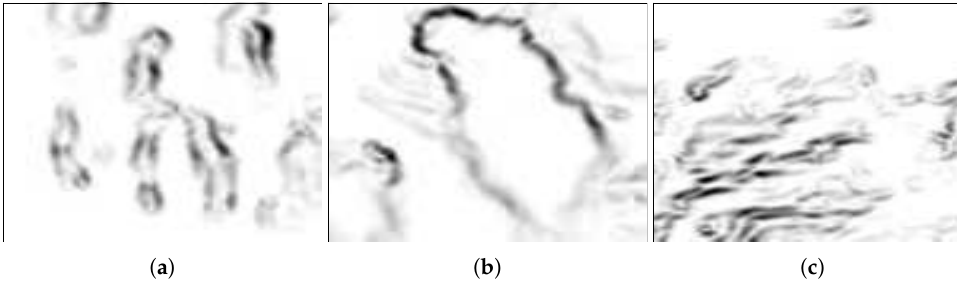
Figure 5. Illustrations of cloud edge suppression based on structure tensor measures. ( a ) Ragged cloud edge; ( b ) strong cloud edge; ( c ) fluffy cloud